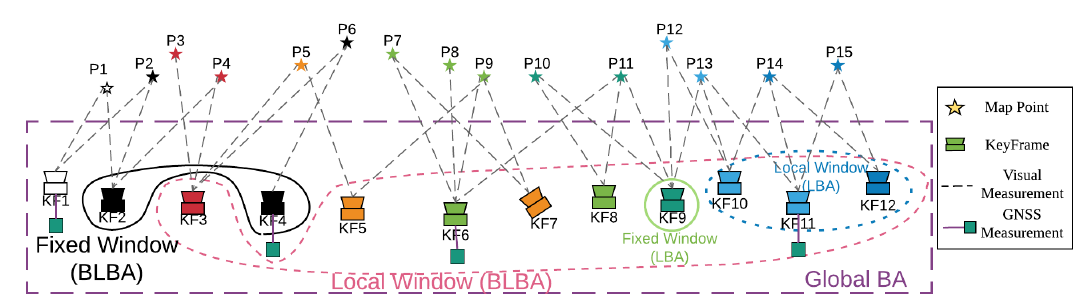
Figure 5. Global Navigation Satellite System–visual-ORB–simultaneous localization and mapping (GVORB) graph optimization model for the local mapping, global bundle adjustment (GBA), and